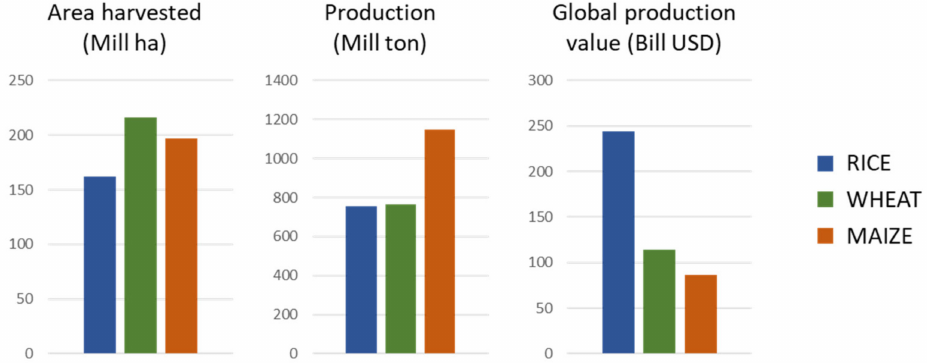
Figure 1. Global data illustrating the agricultural and economic relevance of rice, wheat, and maize. Area harvested and production correspond to 2019, while global gross production value corresponds to 2018. (Source: FAOSTAT database, in www.fao.org/faostat, accessed on 27 January